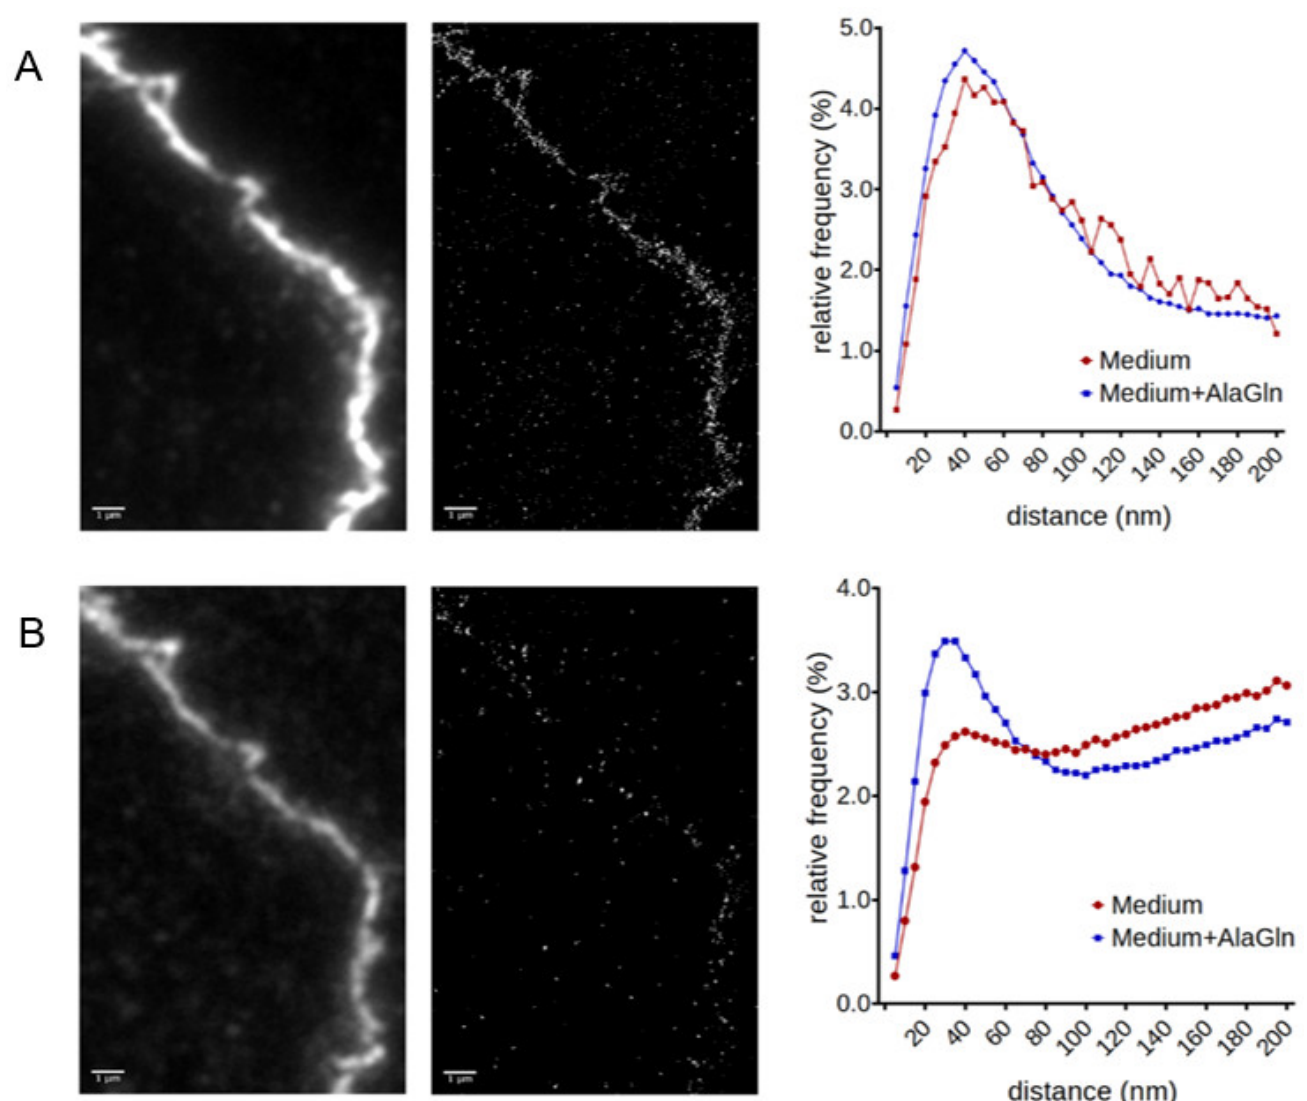
Figure 4. Cluster analysis following single molecule localization microscopy. ZO-1 ( A ) shows comparable frequency of clusters at 40 nm after AlaGln treatment, while clustering it was increased for CLDN5 ( B ) compared to medium treated HUVEC. Left: Widefield images of contact zones. Scale bar = 1µm. Middle: Pointillist images of contact zones created by SMLM Right: Ripley’s pairwise distance frequency histograms indicating cluster formation (peak at smaller distances) in a dispersed environment.